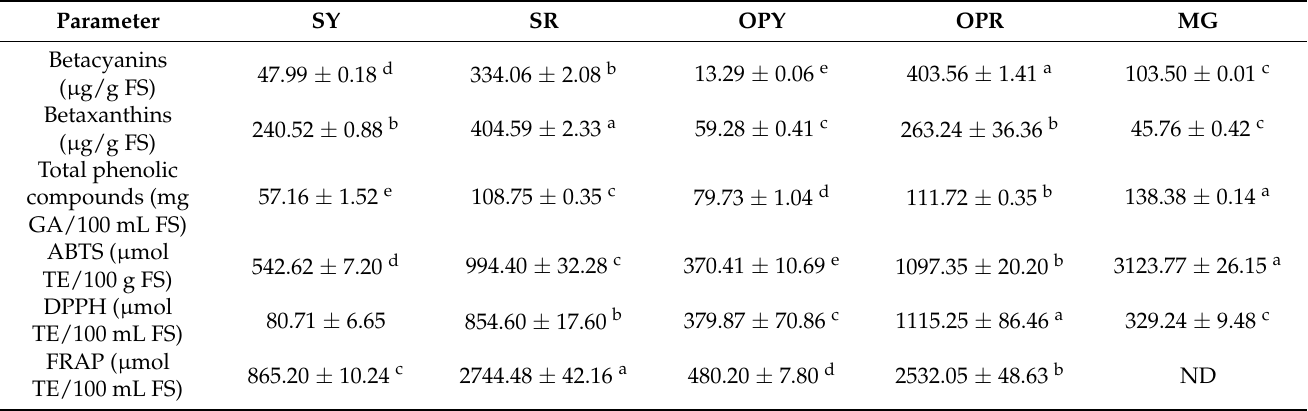
Table 1. Betacyanin and betaxanthin content and antioxidant activity of clarified